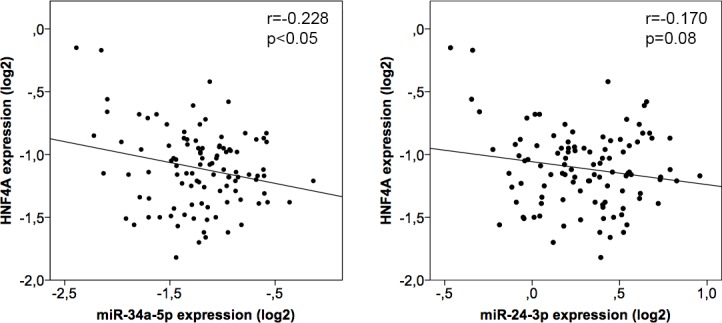
Linear regression analysis between endogenous mature miRNAs (miR-24and miR-34a) levels and HNF4A mRNA.qRT-PCR were performed in total RNA purified from healthy livers (n = 104).Statistical significance was taken as p<0.05. The results are presented as Log2 fold change with respect to the normalization standard.